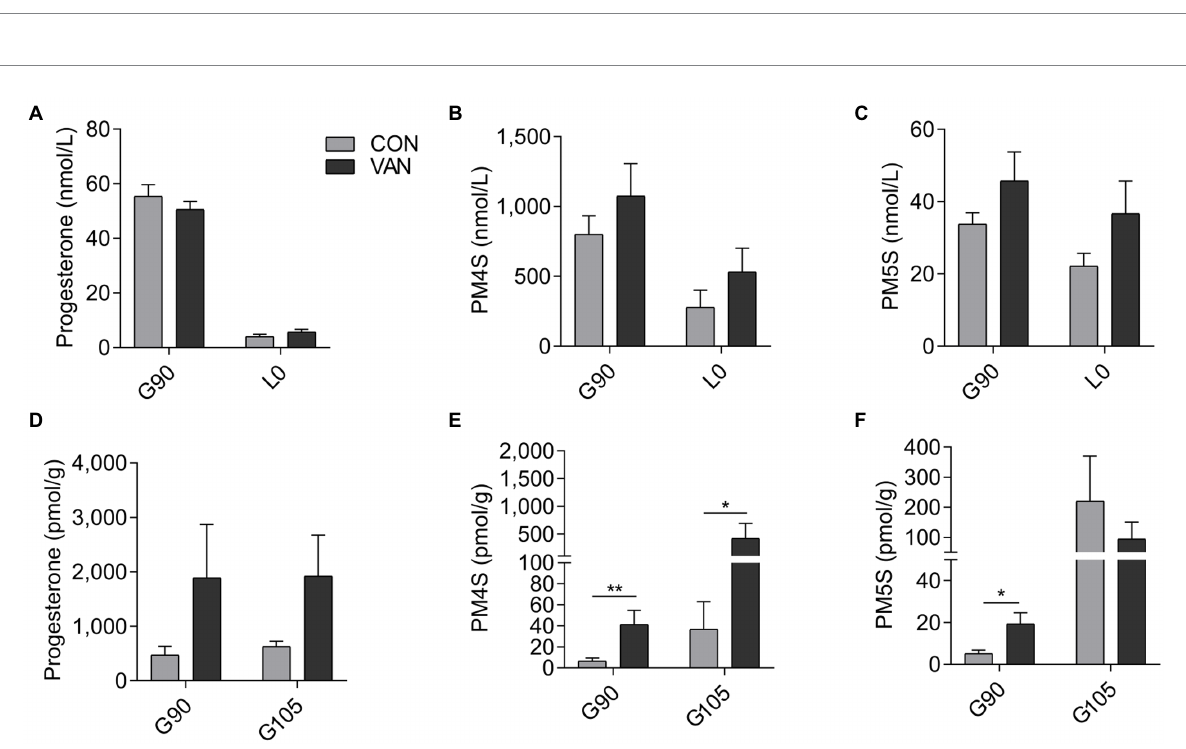
FIGURE 4 (A,B,D) Comparison of fecal TBA and BA profile between CON and VAN at G90 and G105, respectively. (C) Comparison of serum FGF19 levels between CON and VAN at G90 and L0, respectively. Data are shown as means ± SE.